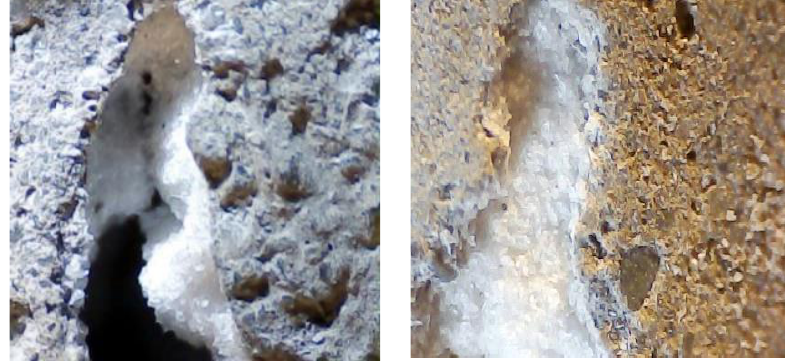
Figure 11. Sealed images of mortar cracks with 6% NC.